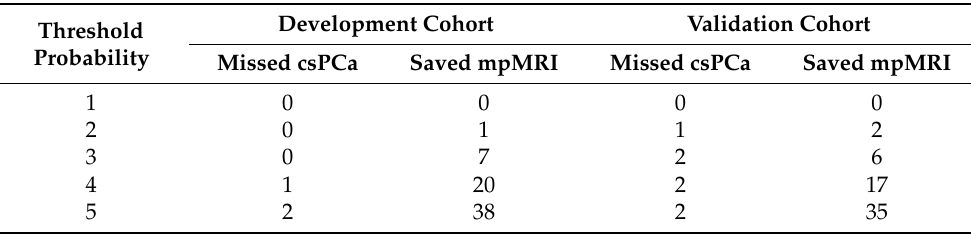
Table 5. Number of missing csPCa and mpMRI scans saved for different thresholds in a hypothetical 1000 cases of PCa suspicion in development and validation